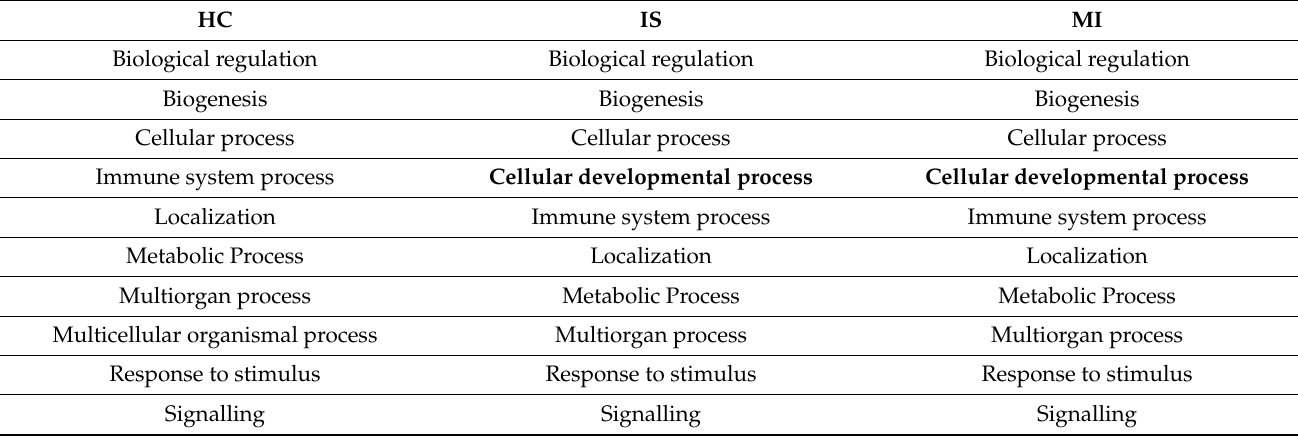
Table 2. The enriched gene ontology biological processes in the healthy controls and patients with ischaemic stroke and myocardial infarction.